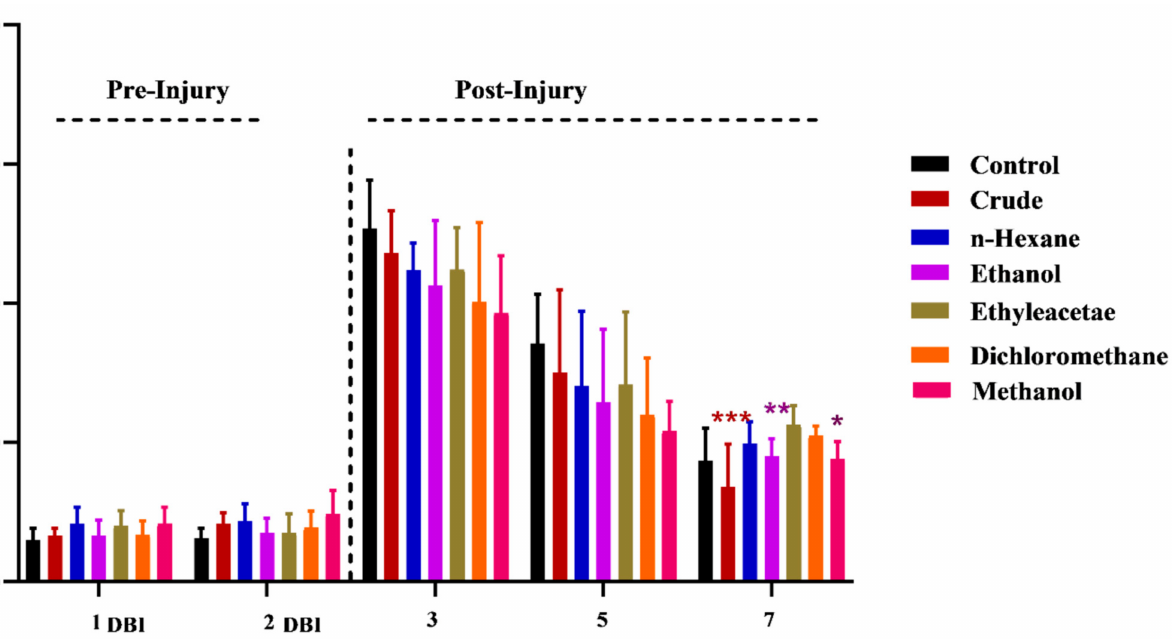
Figure 4. Effects of M. oleifera on recovery of sensory function following sciatic nerve lesion. *, **, *** show the significance of results